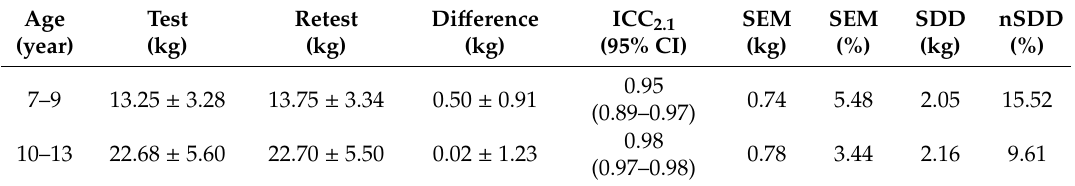
Table 2. The handgrip strength for children (7–9 years) and preadolescents (10–13 years) and reliability statistics for dominant hand. Values are presented as mean ±